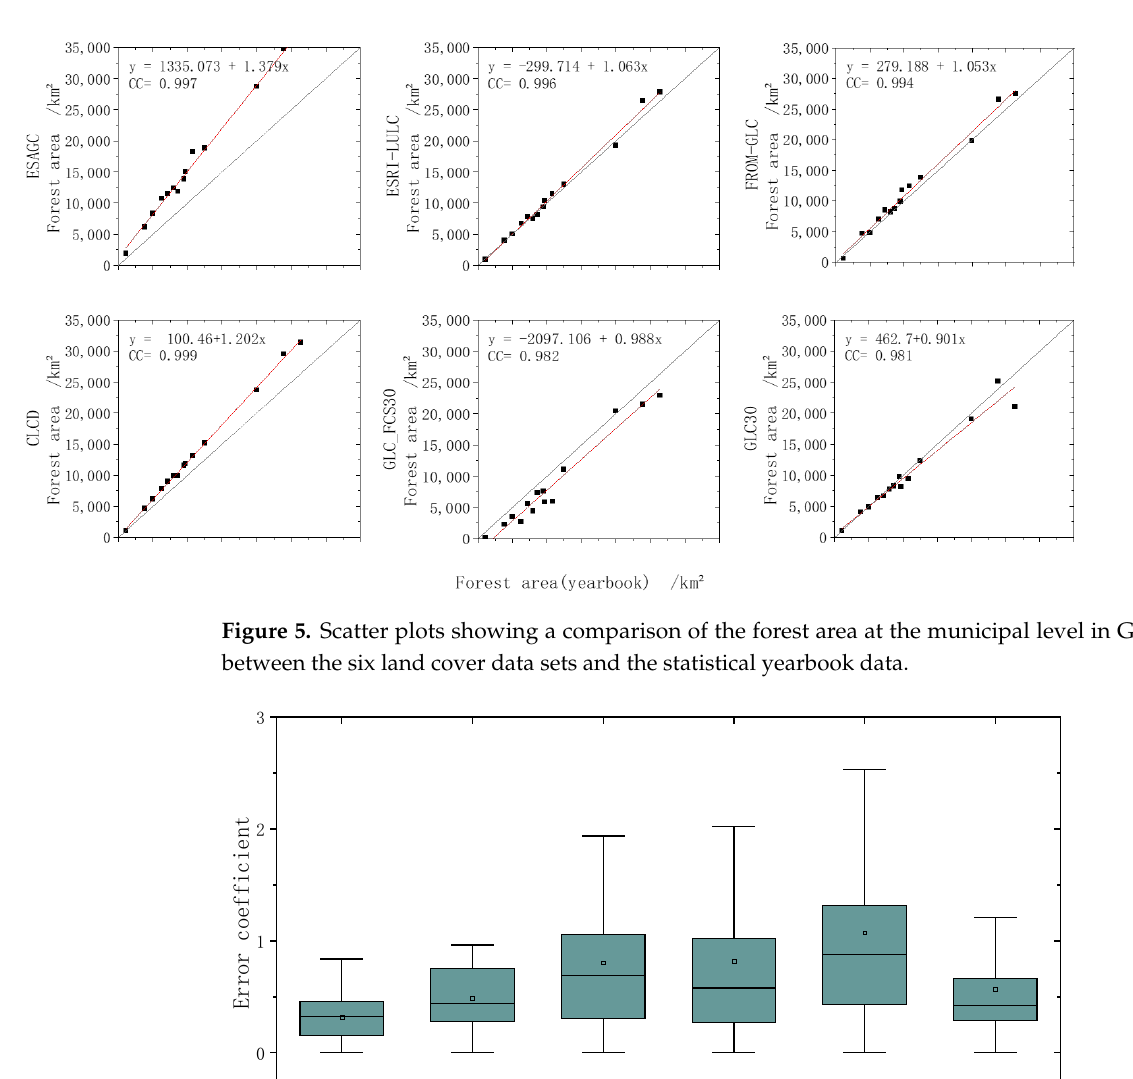
Figure 6. Box plots showing the relative error in forest area between the city-level forest data in the different land cover products and the yearbook data for Guangxi.